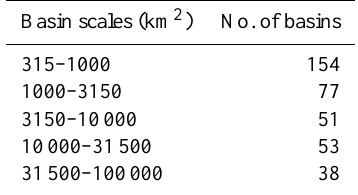
Table 1. Number of basins for each basin-scale